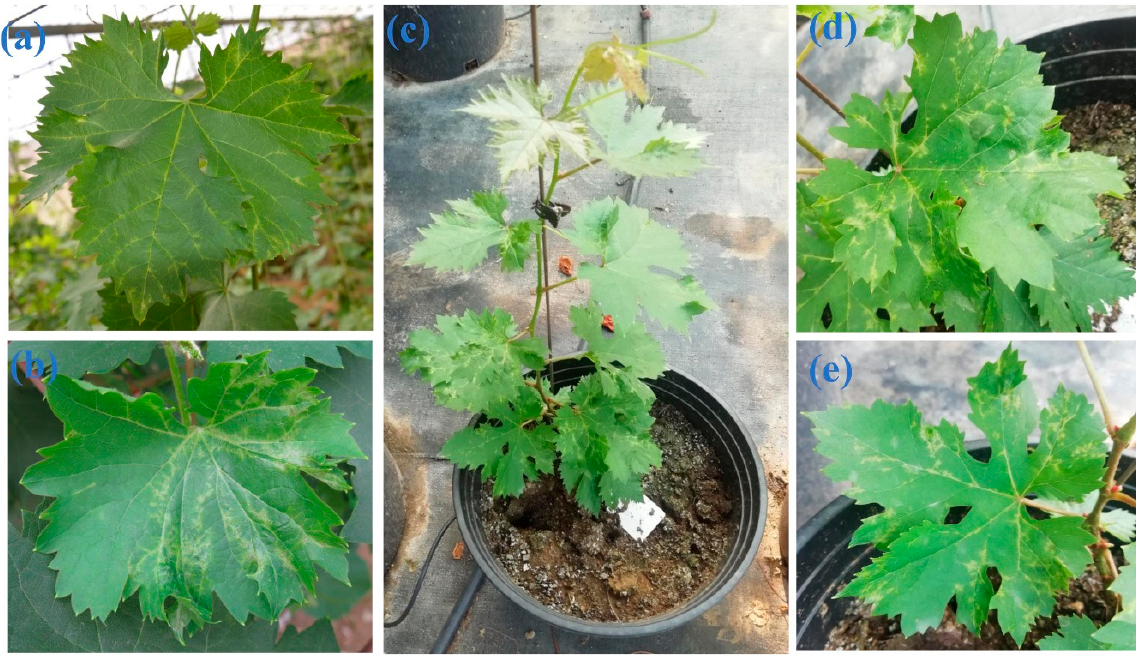
Figure 5. Symptoms on the leaves of a ‘Jumeigui’ grapevine infected with grapevine-associated marafivirus (GaMV). ( a , b ) vein-clearing symptoms on GaMV-infected grapevine leaves; ( c ) cut seedlings propagated from the GaMV-infected plant; ( d , e ) enlarged images of the diseased leaves of ( c ).